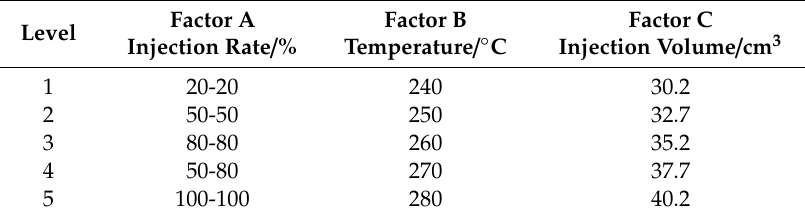
Table 1. The experiment factors and levels.